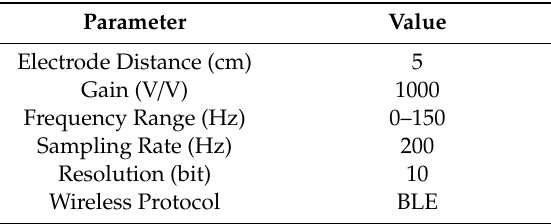
Table 1. Key parameters of the WFEES system.